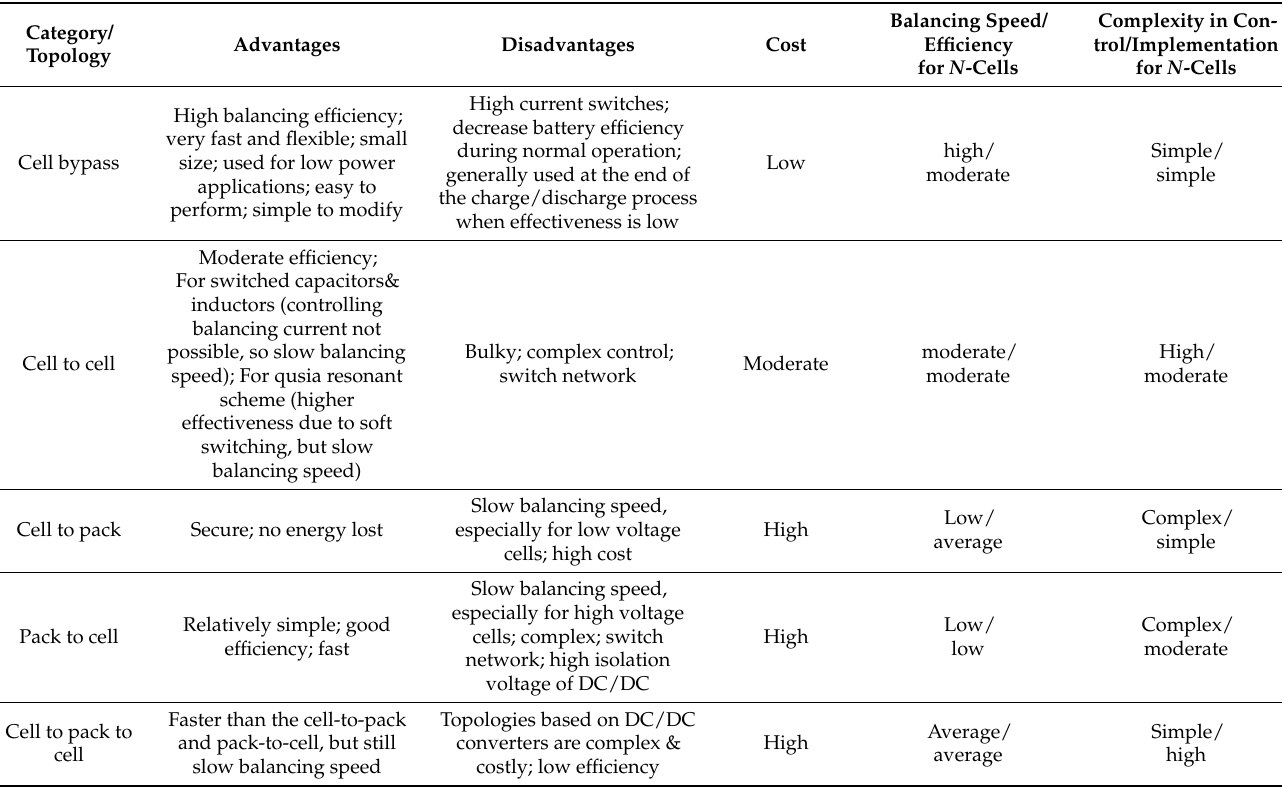
Table 8. Comparison between active cell balancing topologies. Adapted from [6,12,52,53].